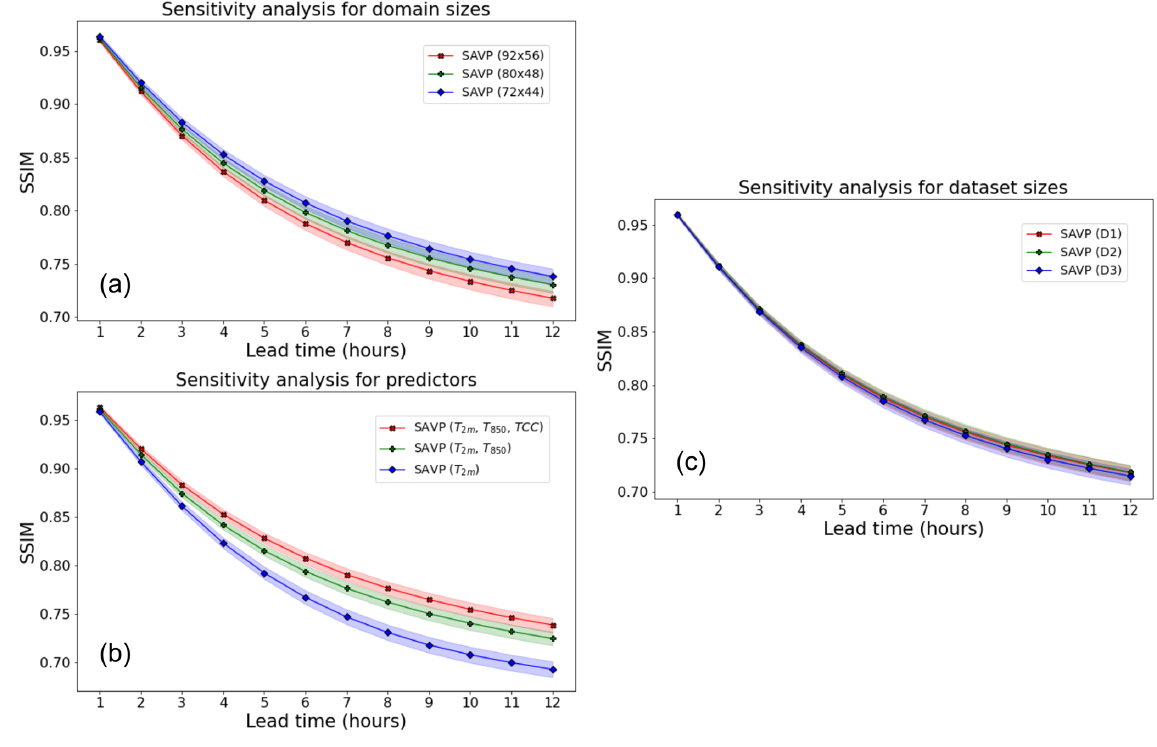
Figure C4. Like Fig. C3 but for SSIM.